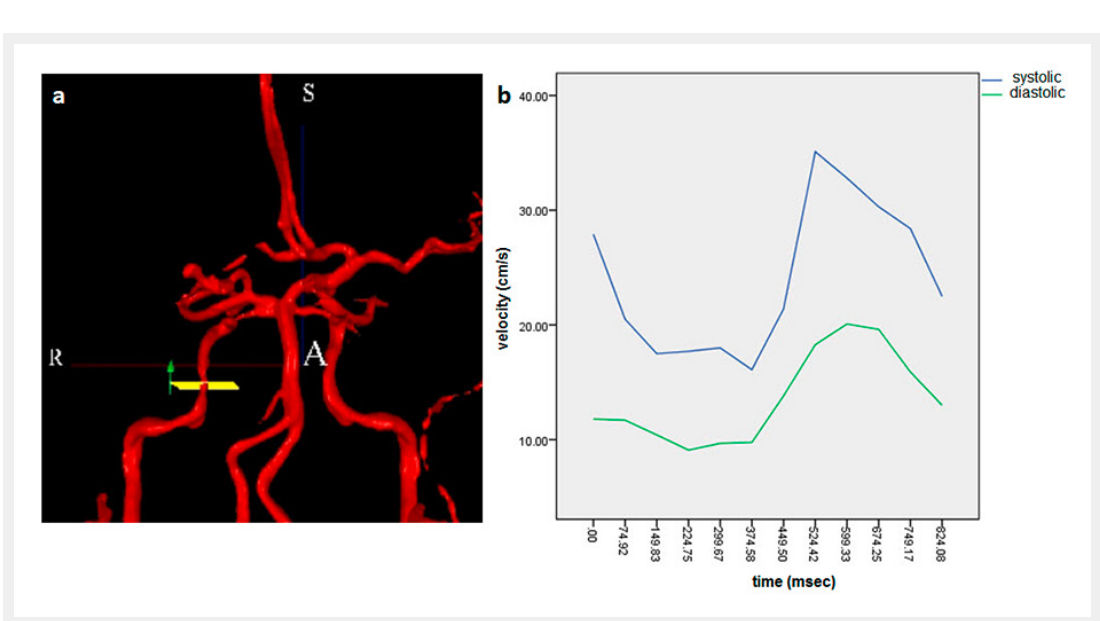
3D time-of-flight magnetic resonance angiography of the intracranial arteries with exactly perpendicular scan planes to vessel axis at target points, the green arrow indicates flow direction (a). Velocities were assessed 12 times each cardiac cycle